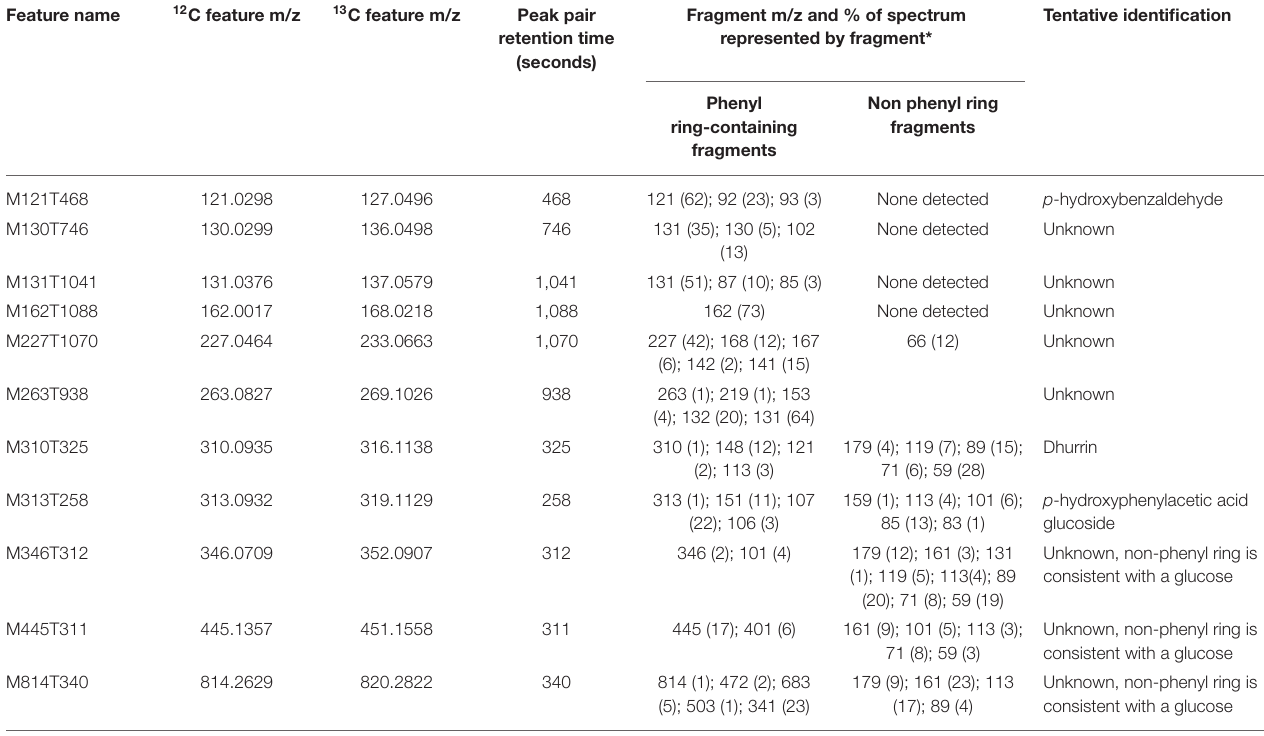
TABLE 2 | Tyr-derived metabolites and their MS/MS fragmentation ratios. Feature